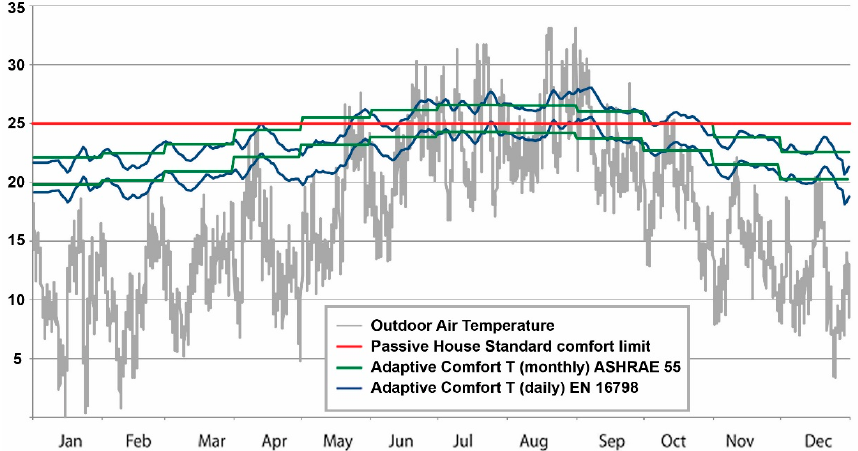
Figure 8. Comparison of three comfort models concerning the outdoor air temperature of Liege, in 2100, under RCP 8.5 scenario.